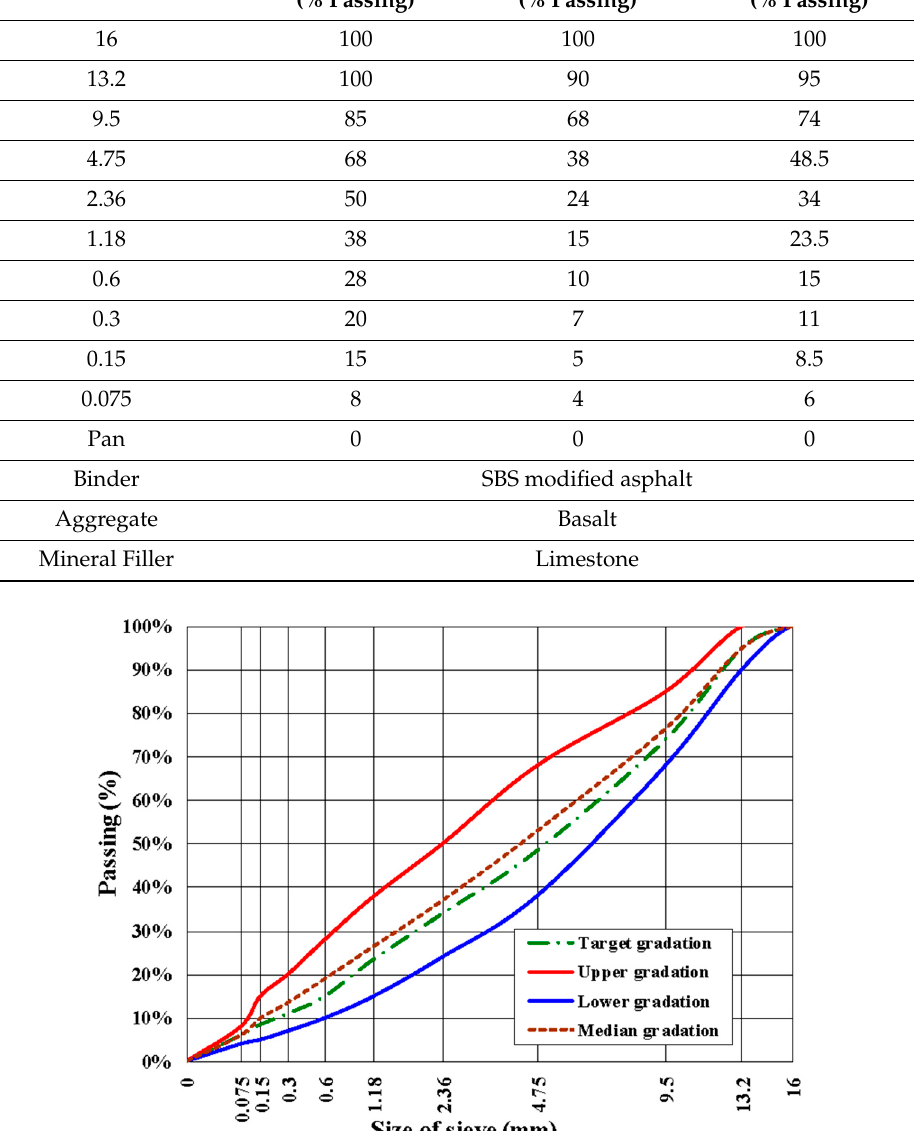
Figure 2. Aggregate gradation curve of dense graded asphalt mixture (AC-13C).